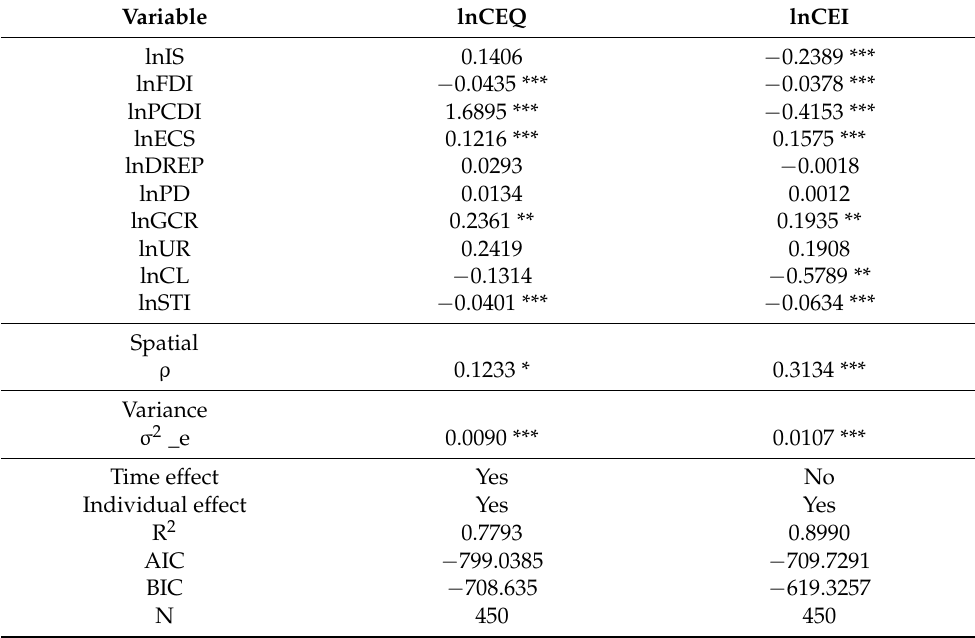
Table 9. Regression results of the region-wide sample of carbon emissions from urban production energy